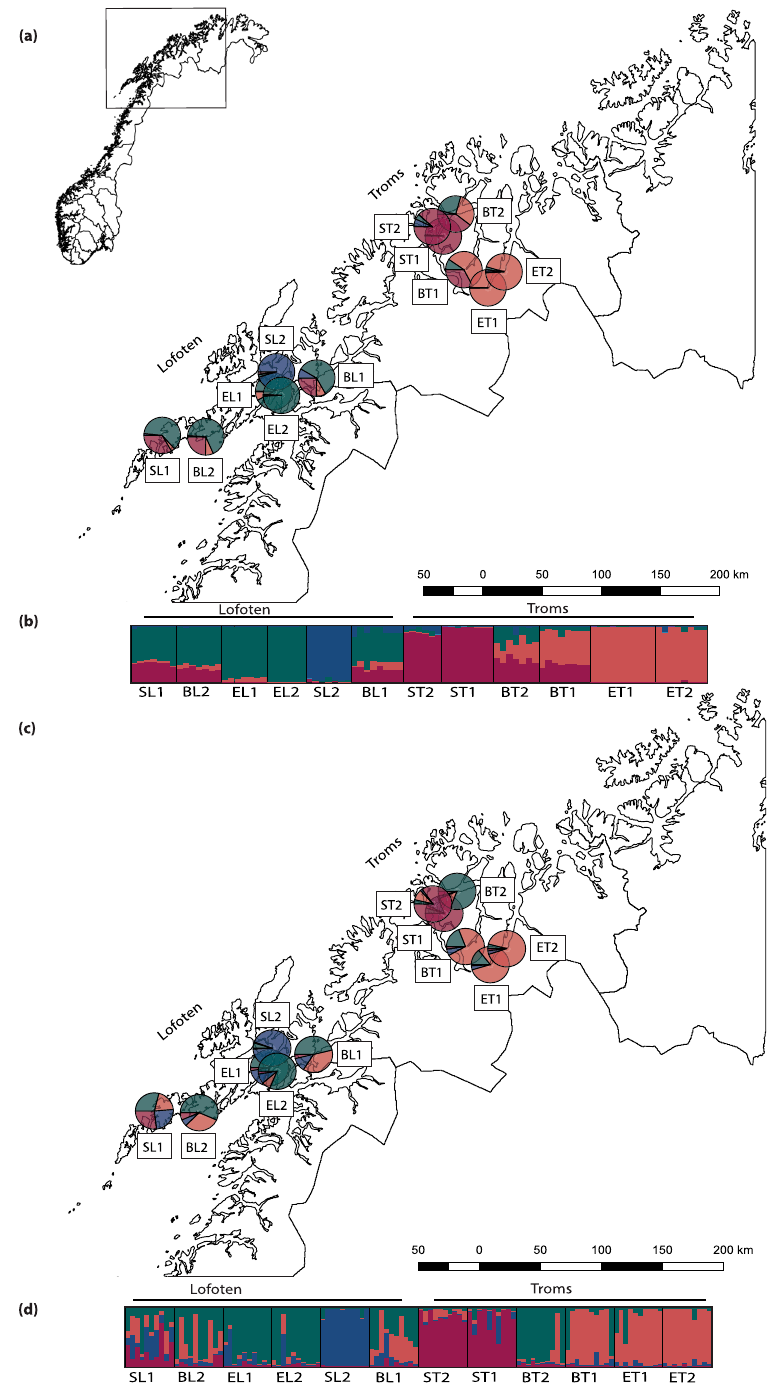
Figure 2. Genetic structure of 12 populations of Cochlearia officinalis in Northern Norway. ( a , b ) Results from STRUCTURE analysis (K = 4) performed on 89 individuals, using 4,296 SNPs from the RADseq data. ( c , d ) Results from STRUCTURE analysis (K = 4) performed on 120 individuals, using microsatellite allele sizes. ( a , c ) Overall assignment of populations to the four STRUCTURE groups visualized by pie charts on a map of Northern Norway. The two sampling areas are indicated as Troms and Lofoten. ( b , d ) Proportional assignment of individuals to the four STRUCTURE groups. Each individual is represented by a bar and populations are separated by a black line. Populations are named according to ecotype (B = beach, E = estuary, S = spring) and geography (T = Troms, L = Lofoten), see Table 1. The map layer was extracted from GADM version 1.0 72